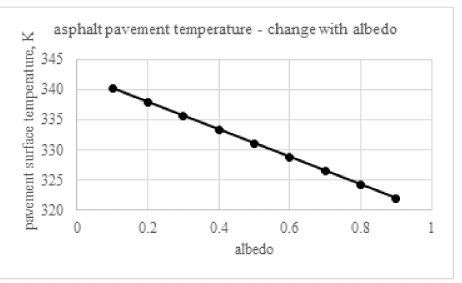
Figure 8. Asphalt pavement top surface temperatures with changing albedo values. Simulations were performed with the concrete pavement under the same conditions.